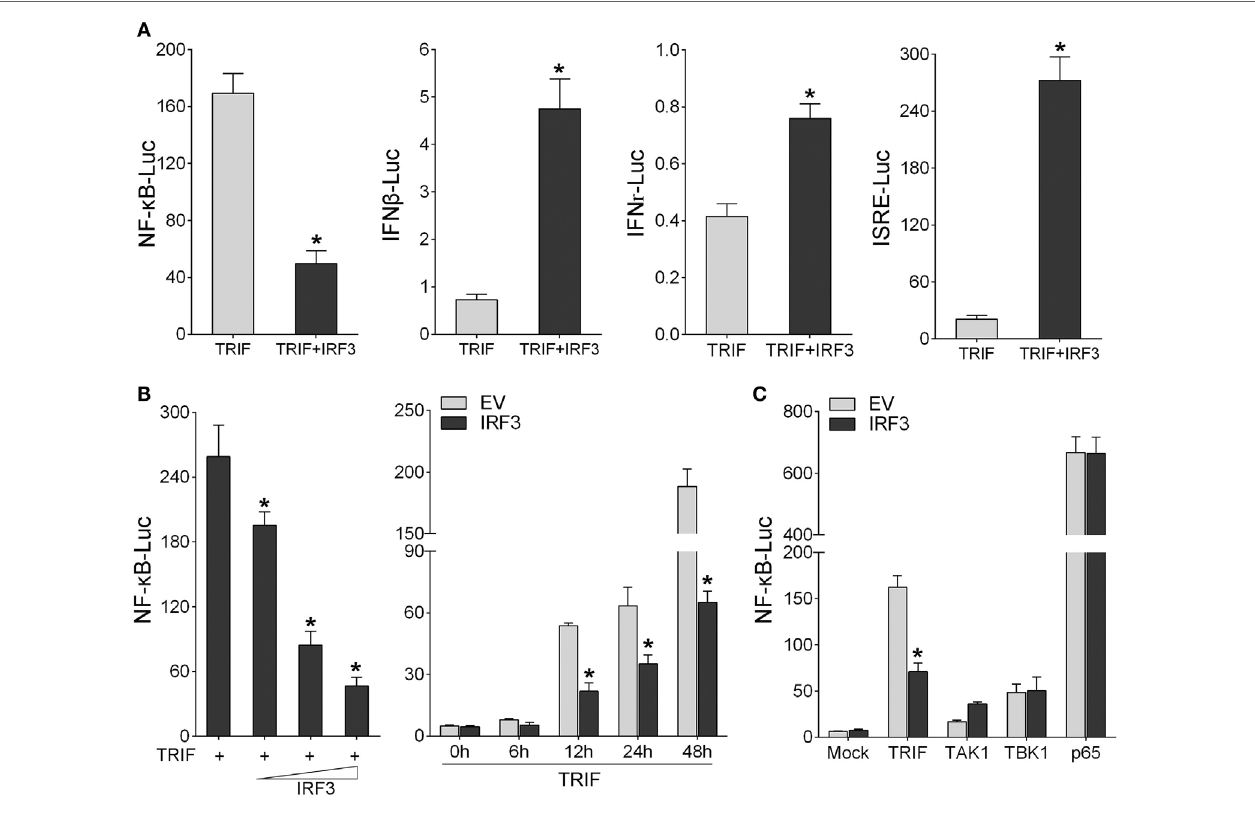
FigUre 3 | IRF3 represses TRIF-mediated NF- κ B signaling pathway. (a) HEK293 cells were co-transfected with TRIF and empty vector or IRF3 together with